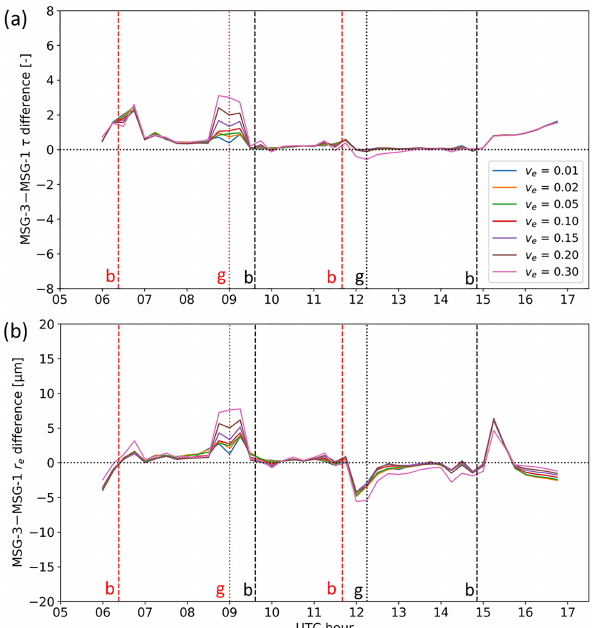
Figure 7. Differences between MSG-3 and MSG-1 retrievals of τ (a) and r e (b) for the seven values of ν e examined on 7 March 2017 over the southeastern Atlantic. The vertical lines represent cloud glory (dotted, denoted with “g”) and cloud bow (dashed, denoted with “b”) geometries for MSG-1 (red) and MSG-3 (black), as in Fig.